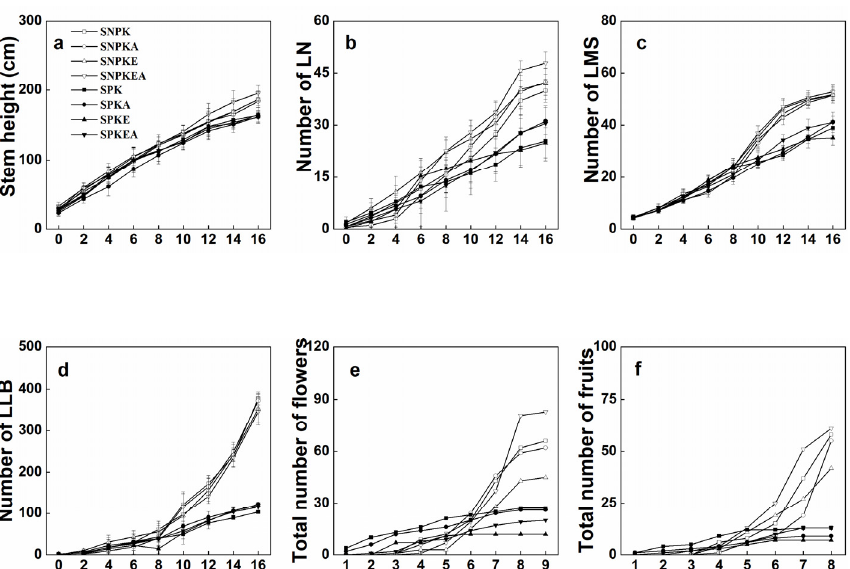
Figure 2. Growth parameters of K. pentacarpos in non-polluted or polluted soil during five months in the presence or absence of NaCl or/and EDDS. The stem height ( a ), number of lateral branch (LB, ( b )), number of leaves on main stem (LMS, ( c )), and number of leaves on lateral branch (LLB, ( d )) were recorded every two weeks until the 16th week ( a – d ). Total number of flowers ( e ) and fruits ( f ) were recorded every ten days from the first day that they appeared, in total, 9 and 8 times, respectively. Each value is the mean of 15 replicates and vertical bars are S.E.